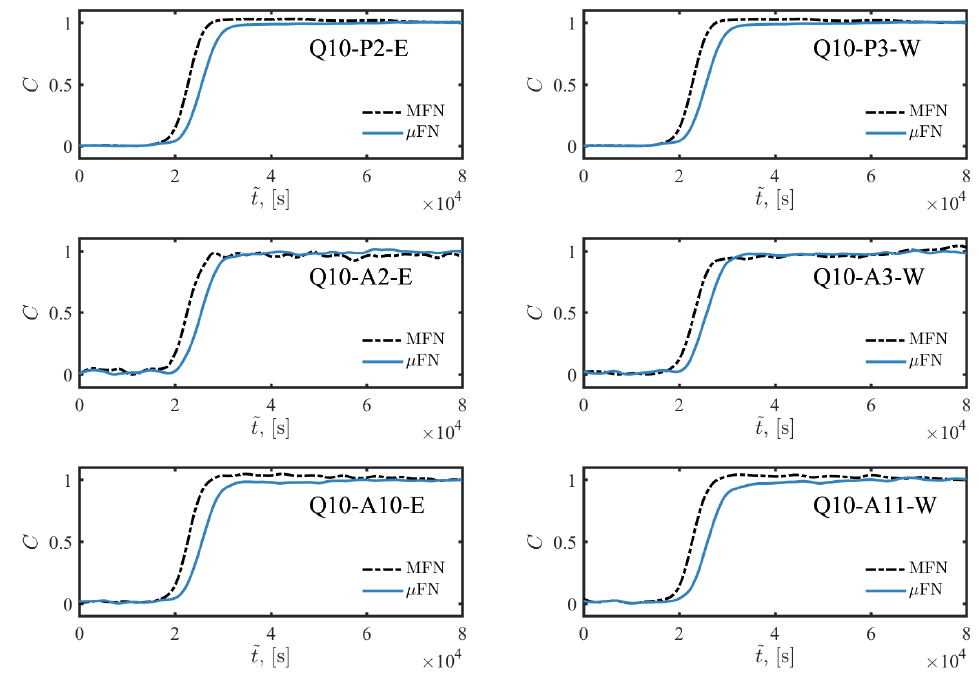
Figure A9. Breakthrough curves measured in physical time in the MFN (dashed line) and µ FN (solid line) at upstream (east) and downstream (west) locations on the same primary (P2–P3), secondary (A10–A11) and tertiary (A2–A3) fracture at Q = 10 µ